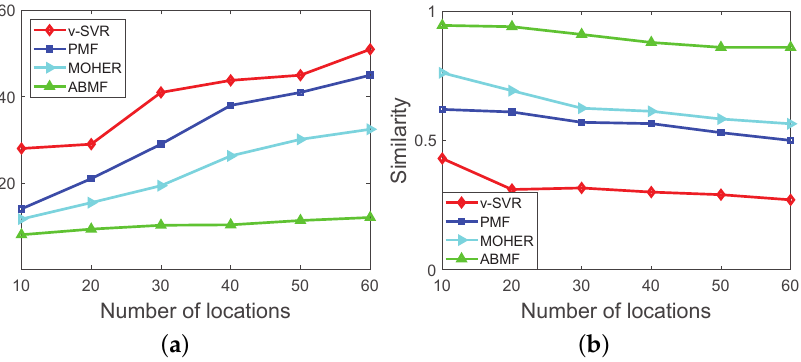
Figure 8. Performance comparison with different scale of simulation dataset: ( a ) Performance on RMSE; ( b ) Performance on